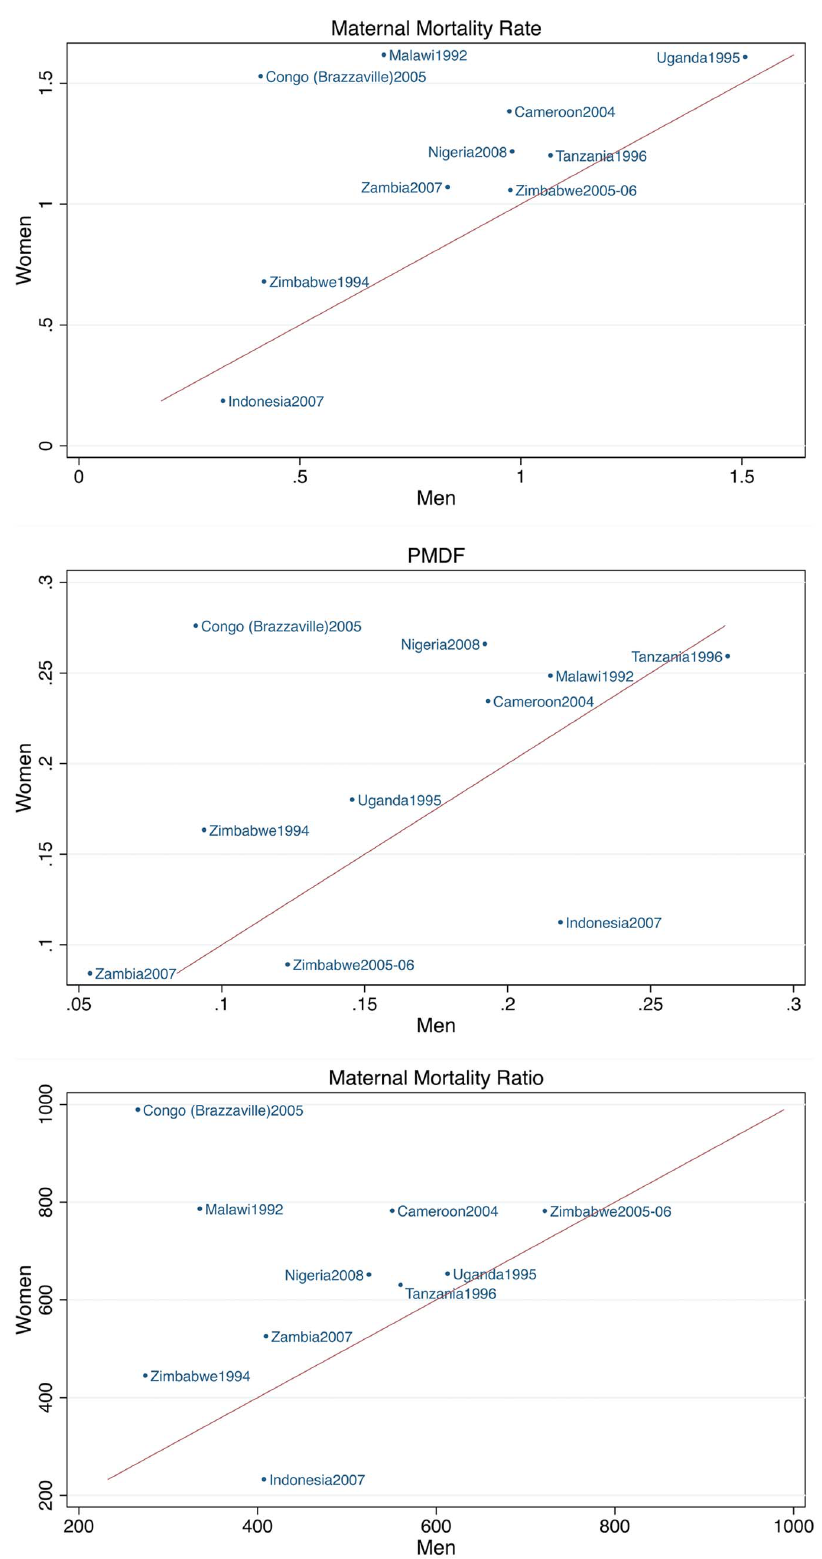
Figure 2. Comparison of the maternal mortality rates (MMRates), the proportions of maternal deaths among deaths of females of reproductive age (PMDFs) and the maternal mortality ratios (MMRatios) obtained from sibling histories reported by women and men for the 1–5 calendar years preceding the survey.